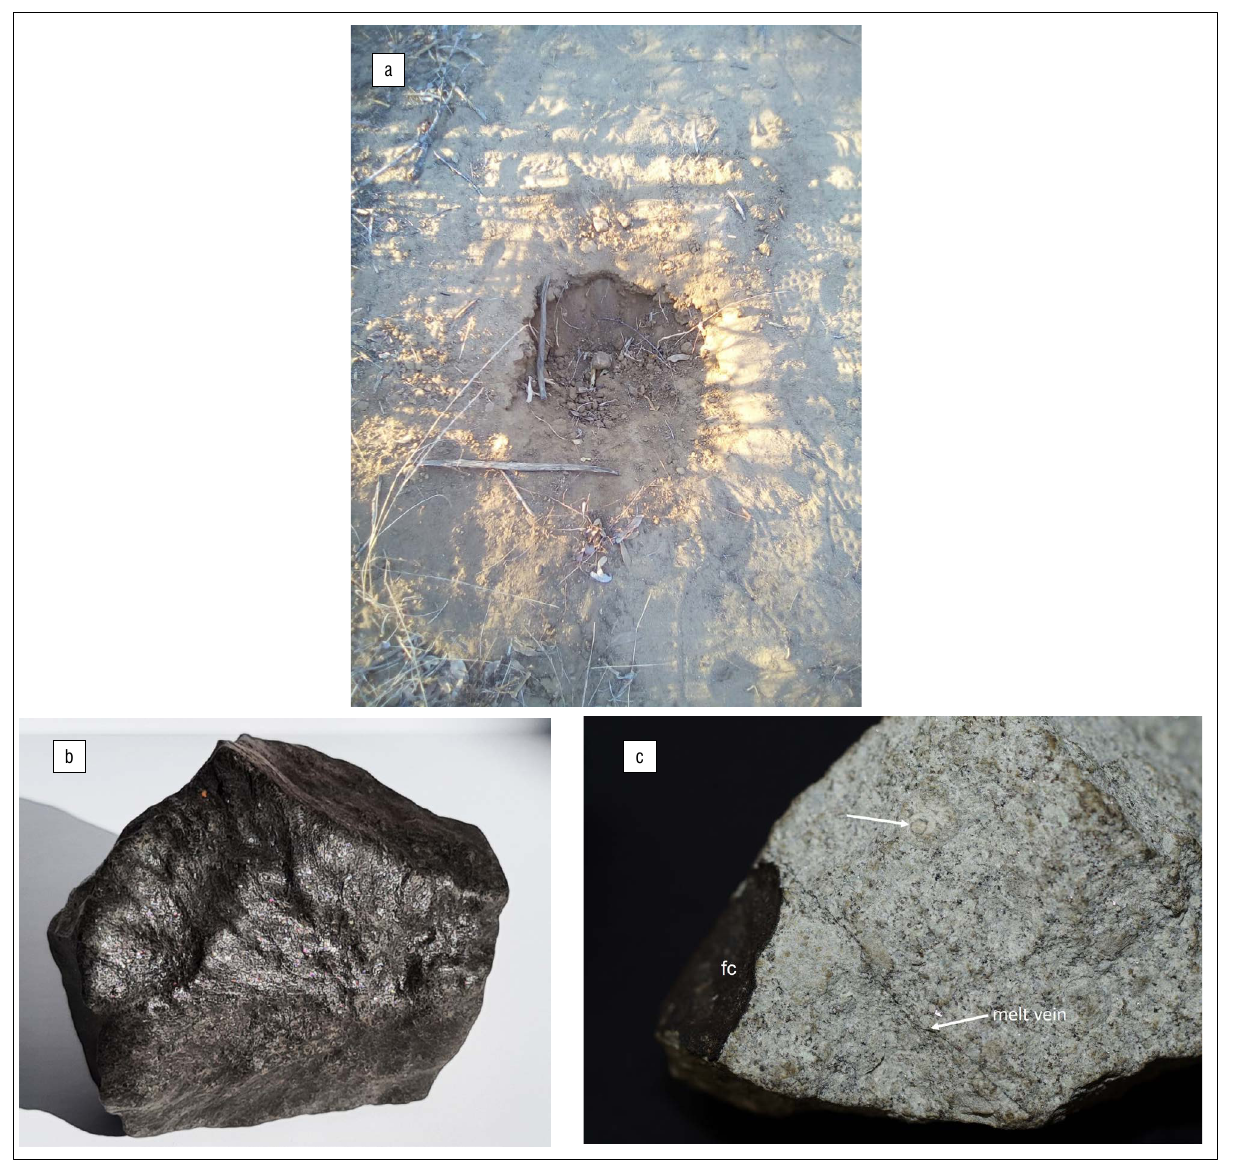
Figure 2: (a) Photograph of plunge pit in sandy soil reportedly caused by an ~1 kg stone at a site on the outskirts of Benenitra town, provided to R. Robinson by an anonymous Benenitra resident. The pit is ~40 cm in diameter and appears slightly elongated in a southeast to south-southeast direction (top of image). (b) Typical Benenitra meteorite stone showing the well-preserved black fusion crust with flow striae and relatively angular shape with sharp edges. Base is 43 mm. Photograph: T. Marais. (c) Close-up of stone 2018Ben-1 showing thin remnant fusion crust (fc), and interior comprising millimetre-sized rounded chondrules (arrow), metal-sulfide aggregates (dark or reflective spots), and thin melt veinlet. Sample was likely broken open by the person who found it. Base of photo is 35